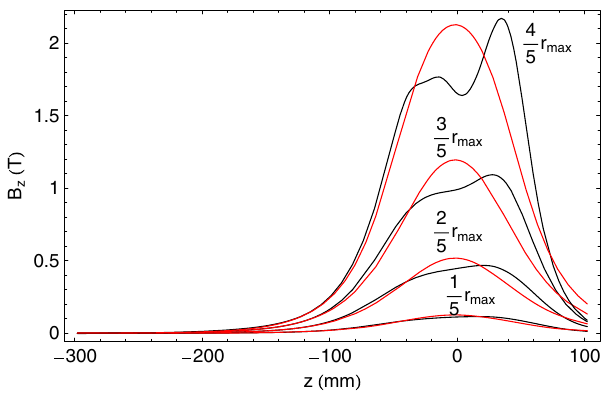
FIG. 9. Longitudinal component of the magnetic field in an HL-LHC inner triplet quadrupole as a function of position along lines of given radius and with cylindrical polar coordinate θ ¼ π = 4 . Each pair of black and red lines shows the field at an 75 mm. = 5 to 4 r = 5 , with r increasing radius, from r max max max ¼ The black lines show the field obtained from the (numerical) magnetic model; the red lines show a symmetrized form of the analytical model (49) – (51), with fit parameters given in Table I = 10 , and b 2 ¼ 2 . 5 . with radius of fit r max